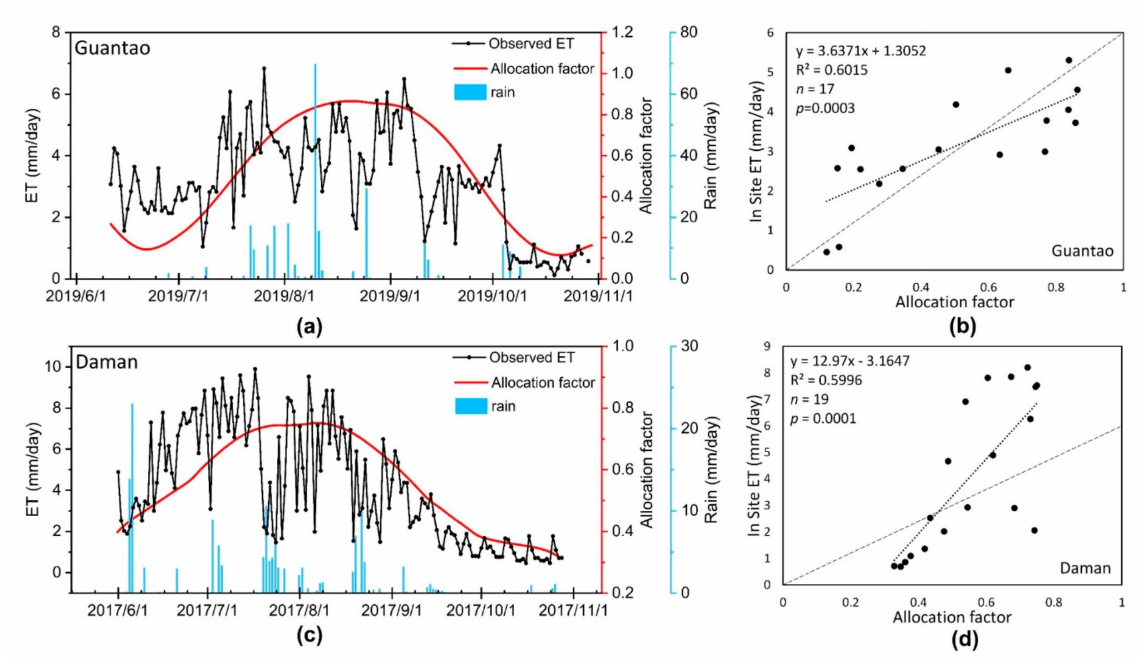
Figure 4. The correlation between the allocation factors and site ET observations. ( a , c ) The daily comparisons of the proposed allocation factor and observed ground ET in Guantao and Daman; the ET observations are derived from the site EC towers, and rainfall data are derived from the site rain gauge observations. ( b , d ) The correlations between the allocation factor and site ET at 8-day intervals. The correlation factor R was greater than 0.77 at both sites and statistically significant ( p <